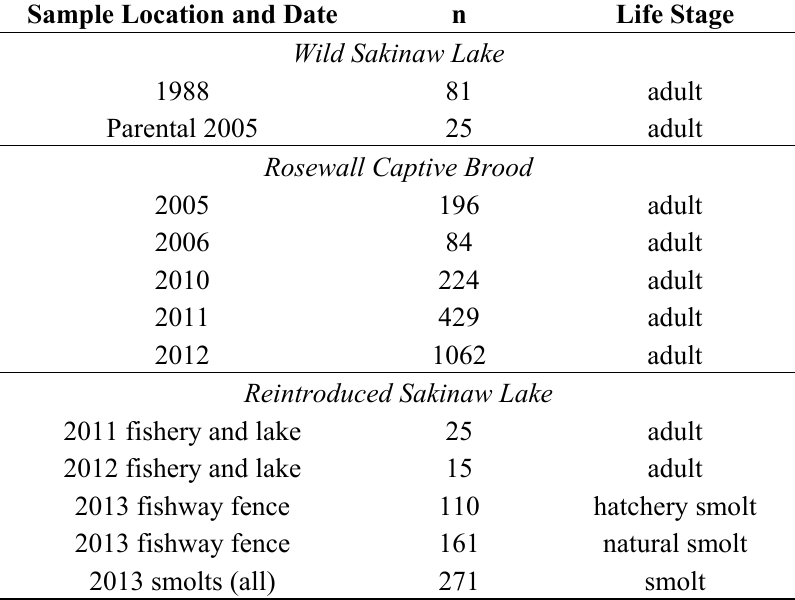
Table 1. Sample sizes (n) of Sakinaw Lake sockeye salmon used for genetic analysis in this study. Fish were sampled from the wild population prior to extirpation, from P2005 founder parents of the captive breeding program, from captive parental fish at Rosewall hatchery, and from reintroduced adult and juvenile Sakinaw sockeye salmon test fisheries or Sakinaw